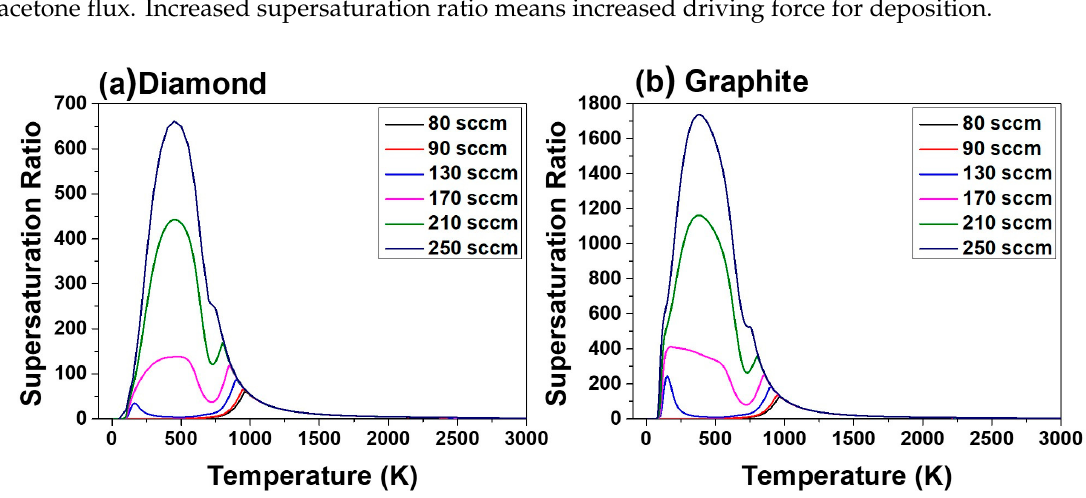
Figure 7. Supersaturation ratio for precipitation of ( a ) diamond and ( b ) graphite for acetone fluxes of 80, 90, 130, 170, 210 and 250 sccm at 4000 Pa as a function of temperature.